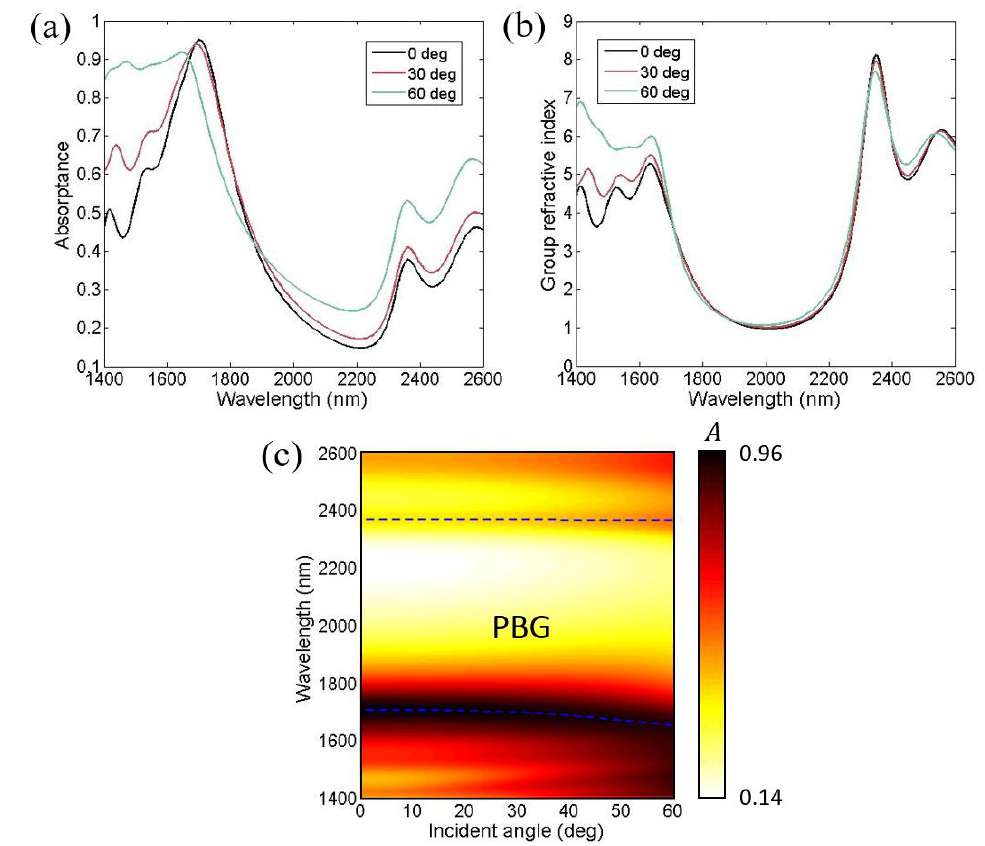
Figure 6. ( a ) Absorptance and ( b ) group refractive index spectra of the designed 1-D PCCH [(EF) 2 D] 6 at different incident angles 0° , 30° , and 60° under TM polarization. ( c ) Absorptance spectrum of the designed 1-D PCCH [(EF) 2 D] 6 as a function of the incident angle under TM polarization.